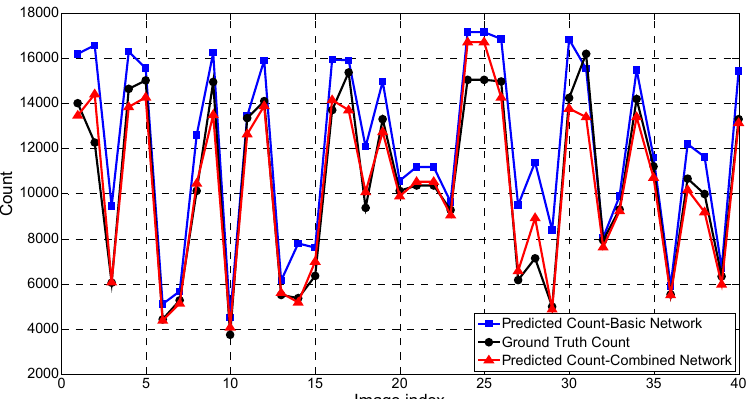
Figure 10. Predicted count obtained from the Combined Network and Basic Network models versus the ground truth count for each of the 40 images in the RSC dataset.